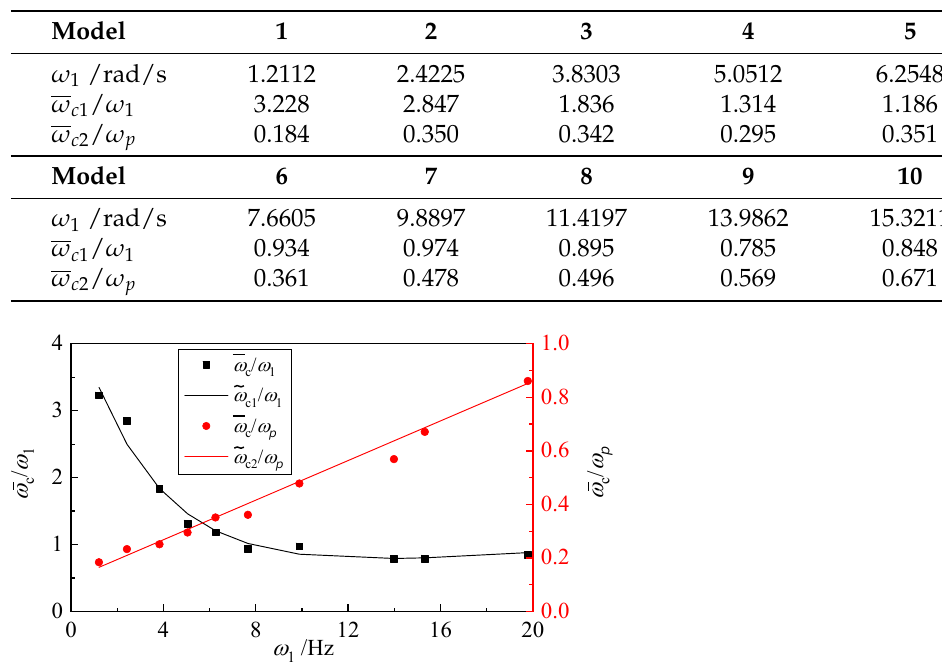
Table 4. Ratios of the average values of ω c to ω 1 and ω p .